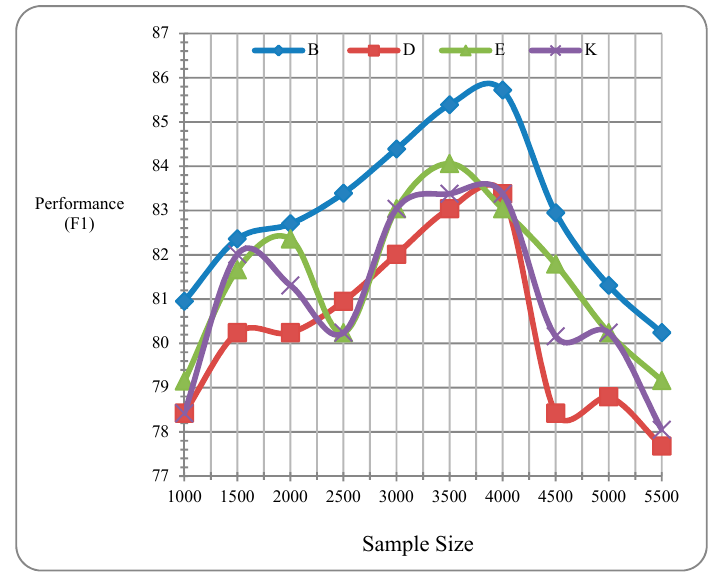
Figure 3. Performance ( x -axis) of integrated supervised and semi-supervised learning models with different sizes of samples ( y -axis).